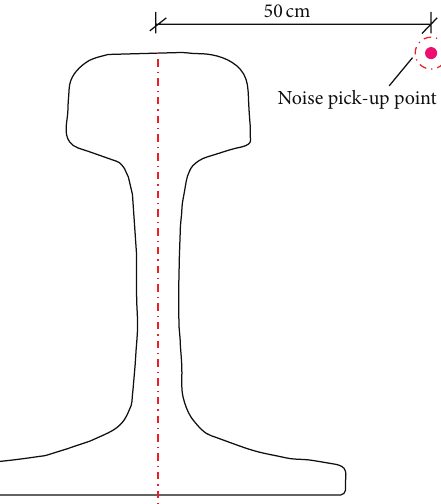
Figure 16: Location of the noise pick-up point.